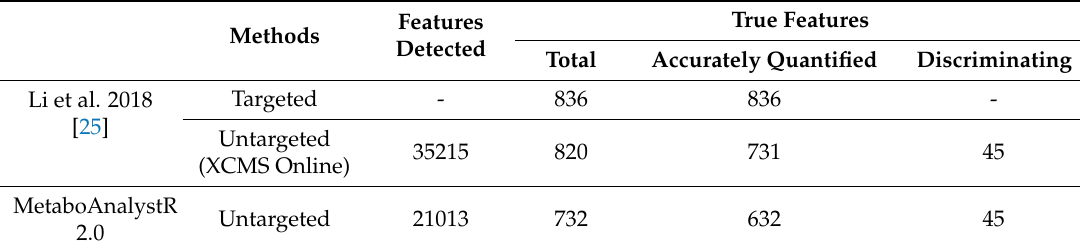
Table 1. Comparison of peak identification and quantification accuracies using the benchmark dataset between MetaboAnalystR 2.0 and the original manuscript using XCMS